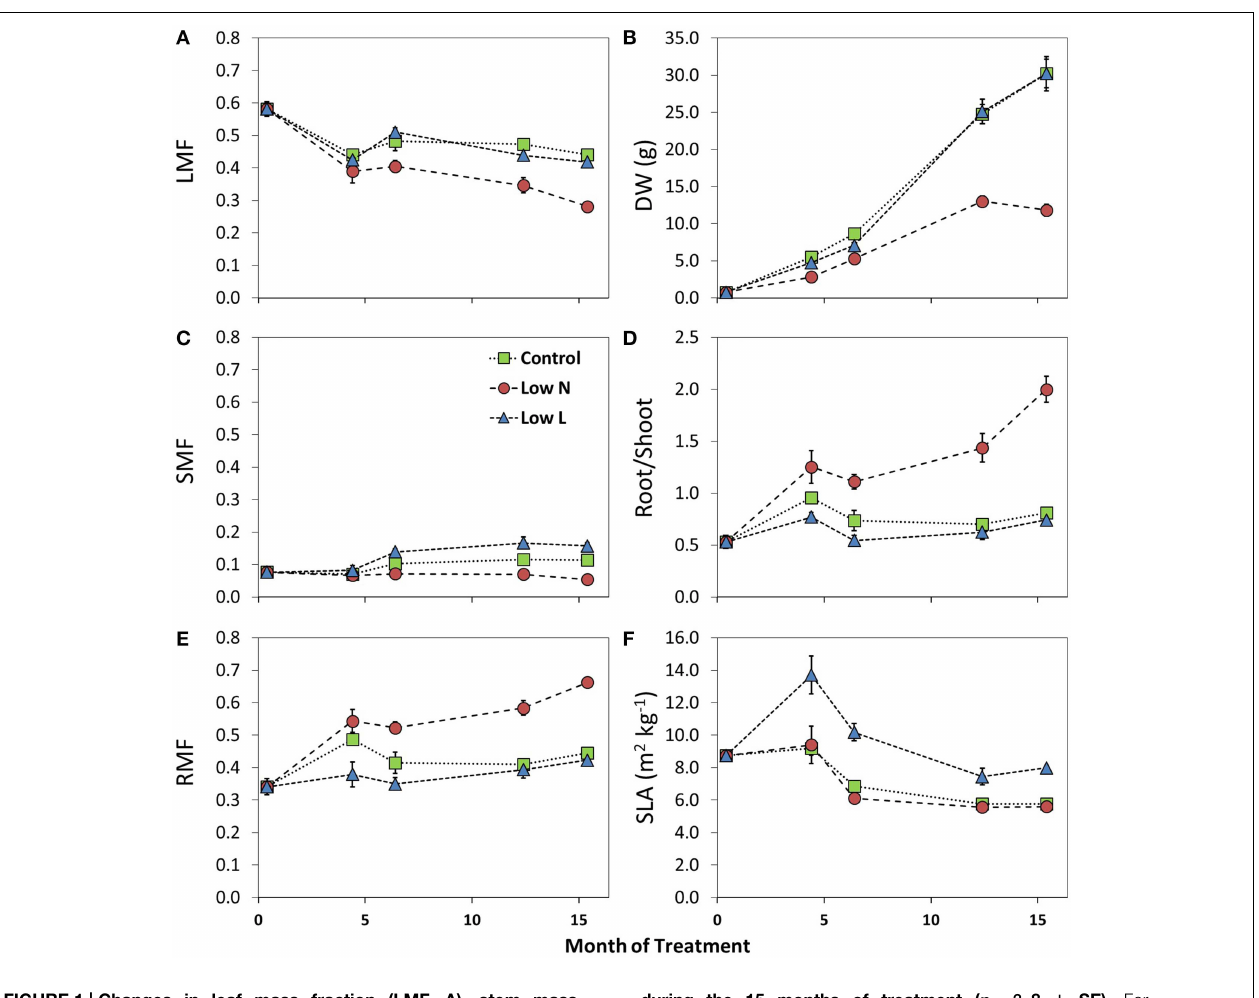
FIGURE 1 | Changes in leaf mass fraction (LMF, A), stem mass fraction (SMF, C), root mass fraction (RMF, E), dry weight (DW, B), Root/Shoot ratio (D), and specific leaf area (SLA, F)